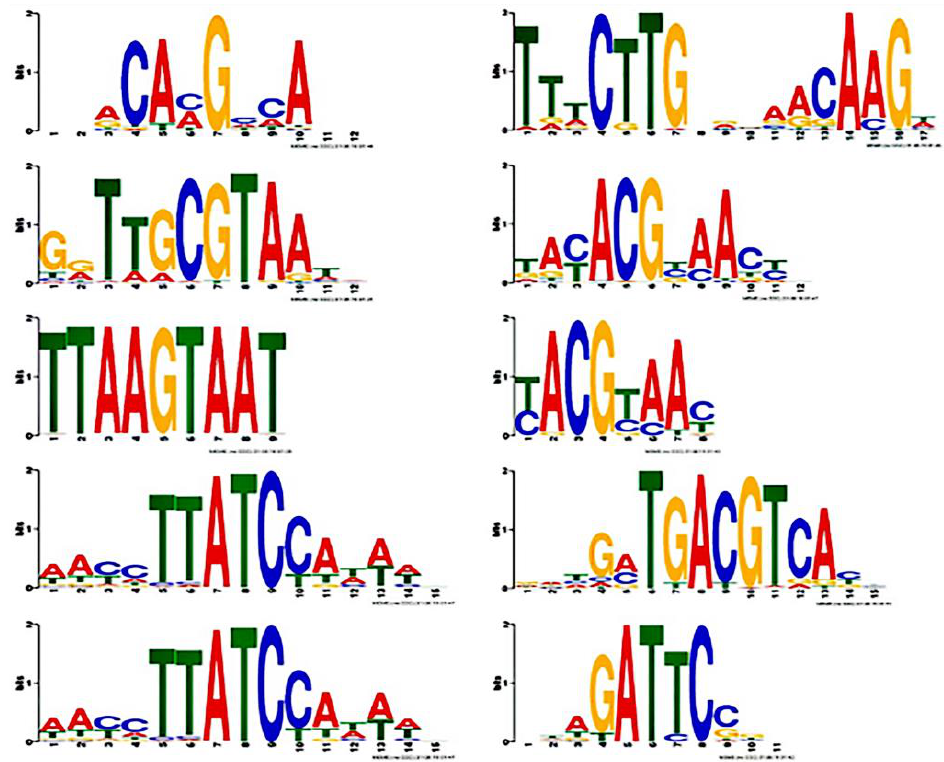
Figure 11. Prediction of possible cis − acting elements bound by key transcription factors VcNAC, VcMYB, VcWRKY, VcbZIP, VcPHL, and other families.